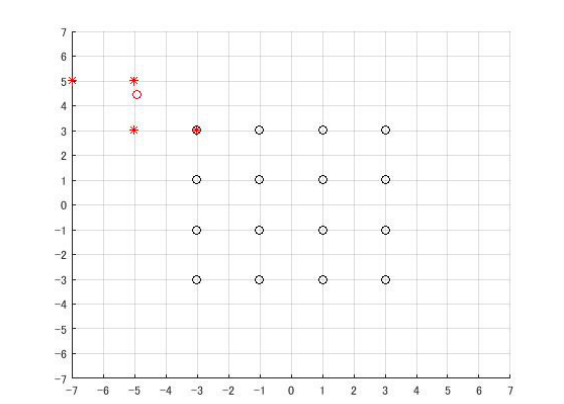
Fig. 6. Received signal (red circle mark) and search integer coordinate set a (red asterisk).